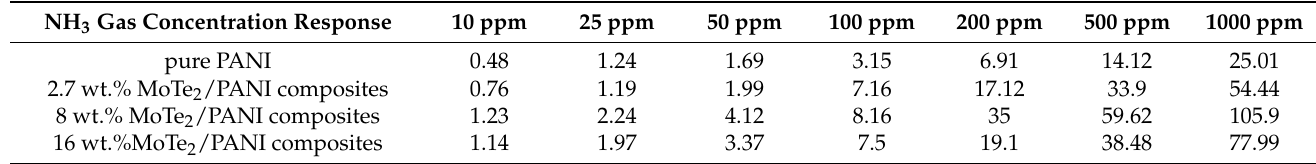
Table 1. The response values of sensors prepared in this work regarding NH 3 gas.